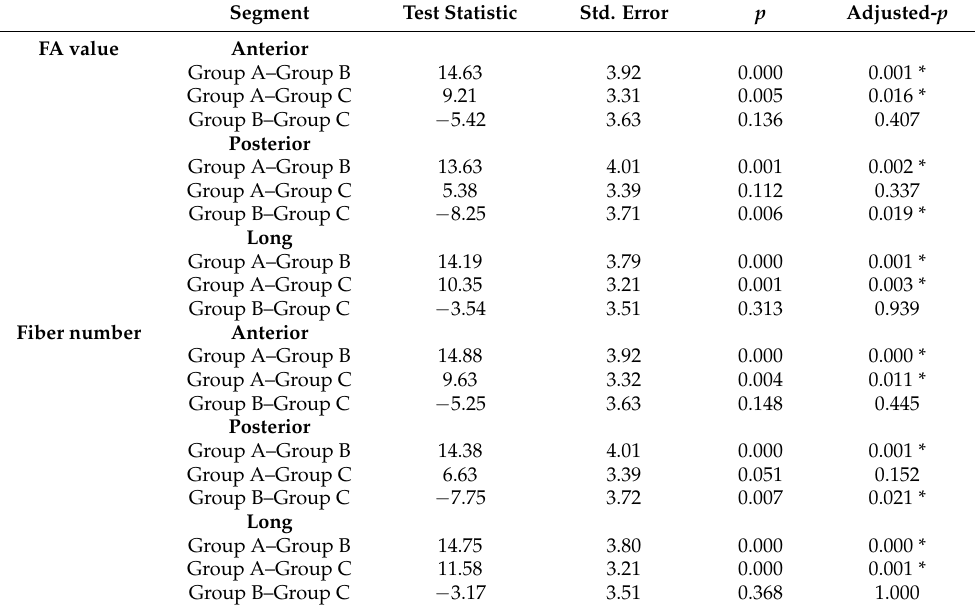
Table 7. Multiple comparison tests for diffusion indices in the left AF